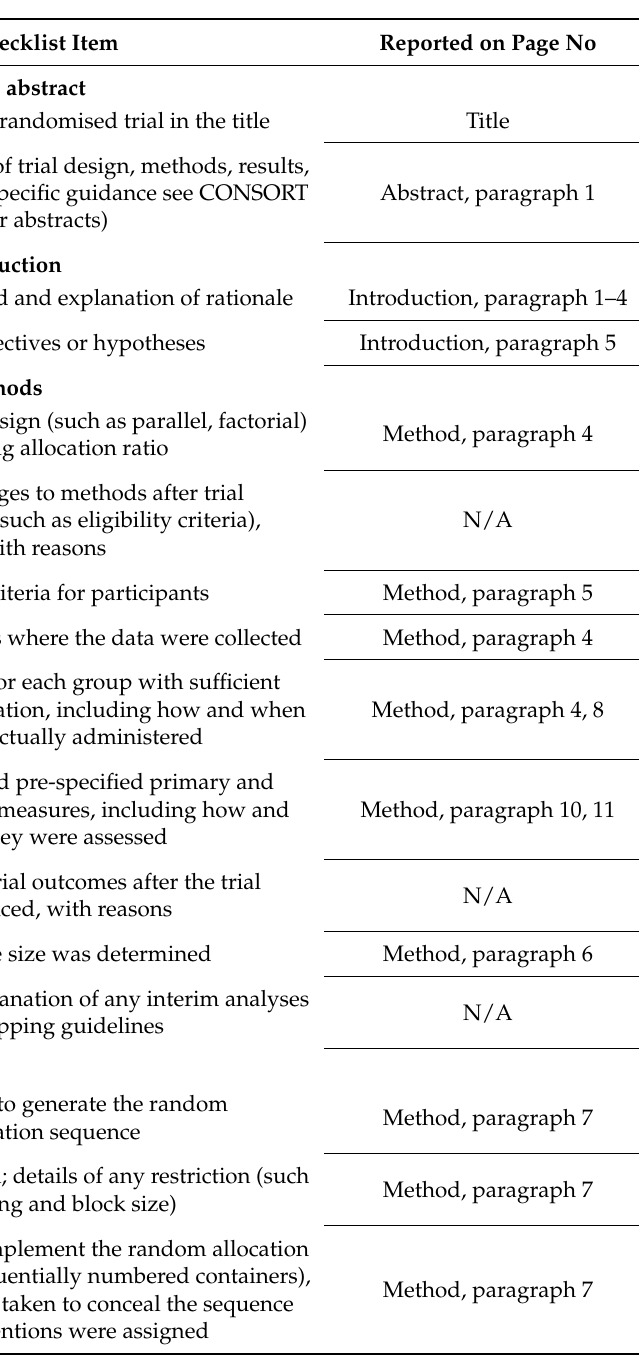
Table A2. CONSORT 2010 checklist of information to include when reporting a randomised